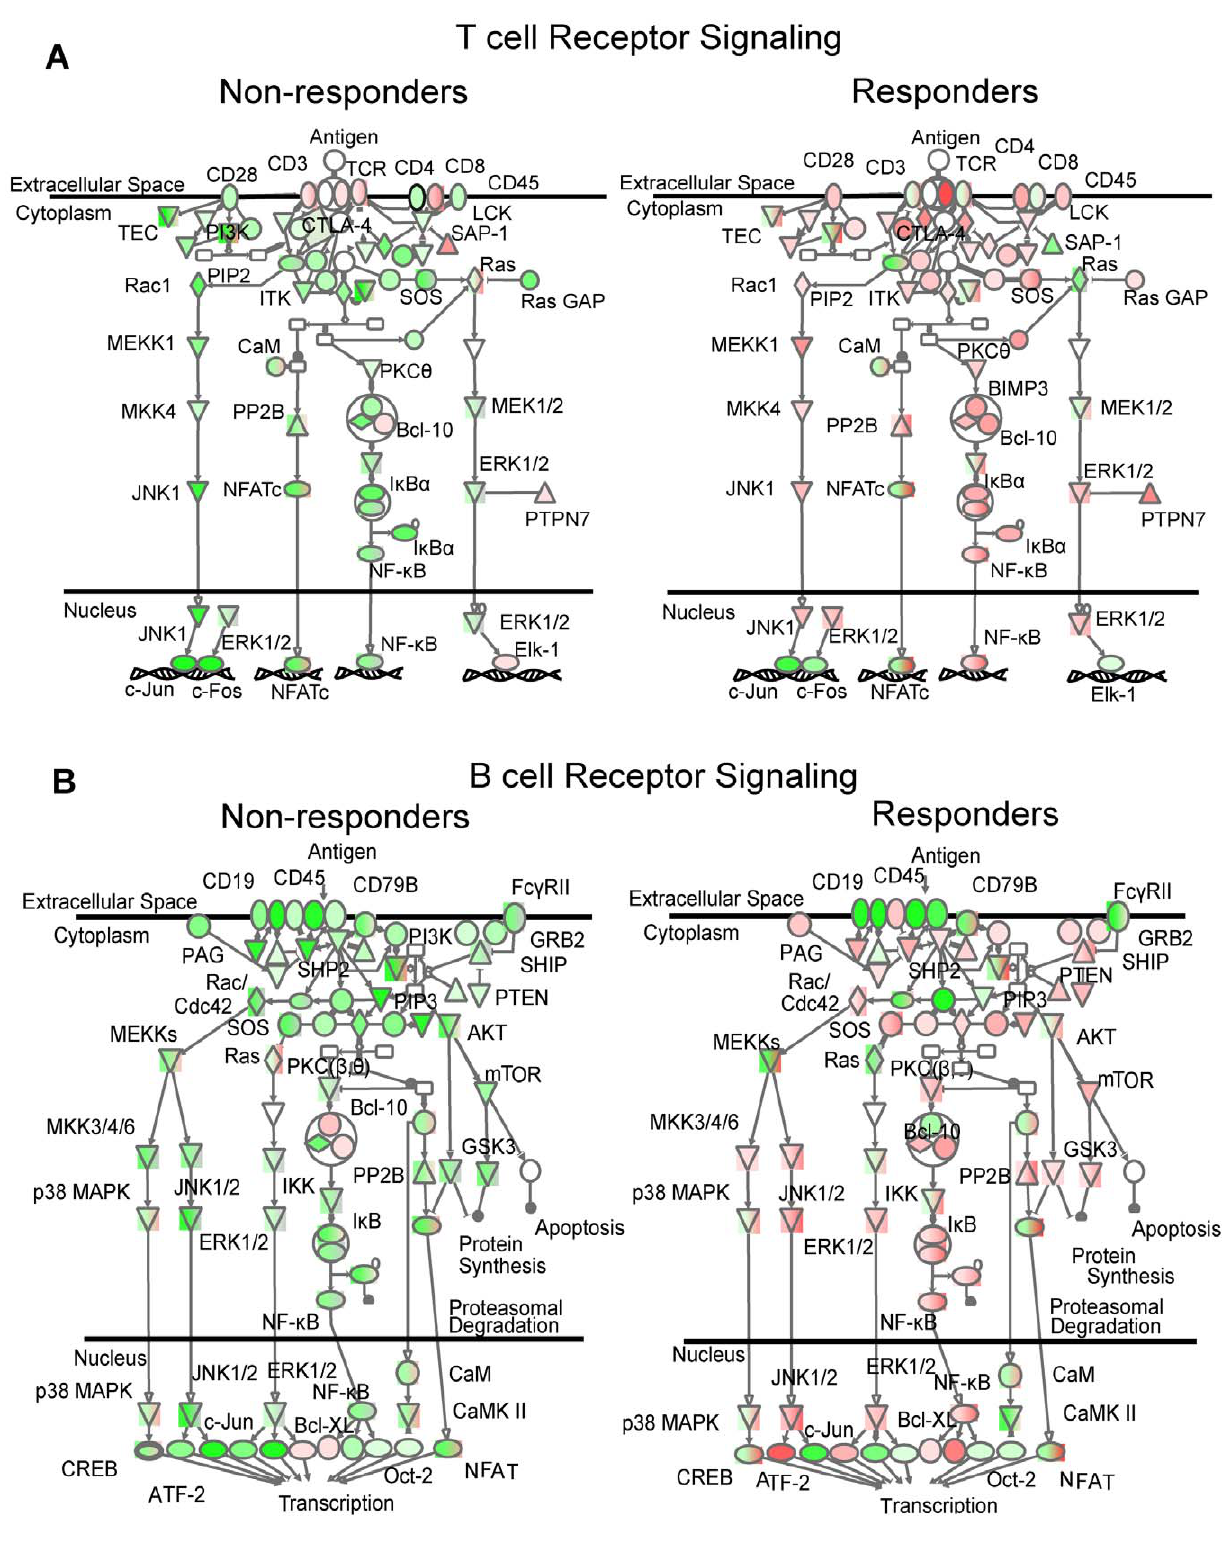
Figure 3. Separate comparison of gene expression post-treatment versus gene expression pre-treatment for responding and non- responding patients. Ingenuity pathway analysis suggests differences in regulation of T-cell (Figure 3A) and B-cell (Figure 3B) receptor signaling. Most of the molecules in the B-cell as well as in the T-cell receptor pathway are down-regulated for non-responding patients upon immunotherapy (POST , PRE), whereas gene expression of the same molecules is up-regulated for responding patients (POST . PRE). Red: up- regulation, Green: down-regulation.